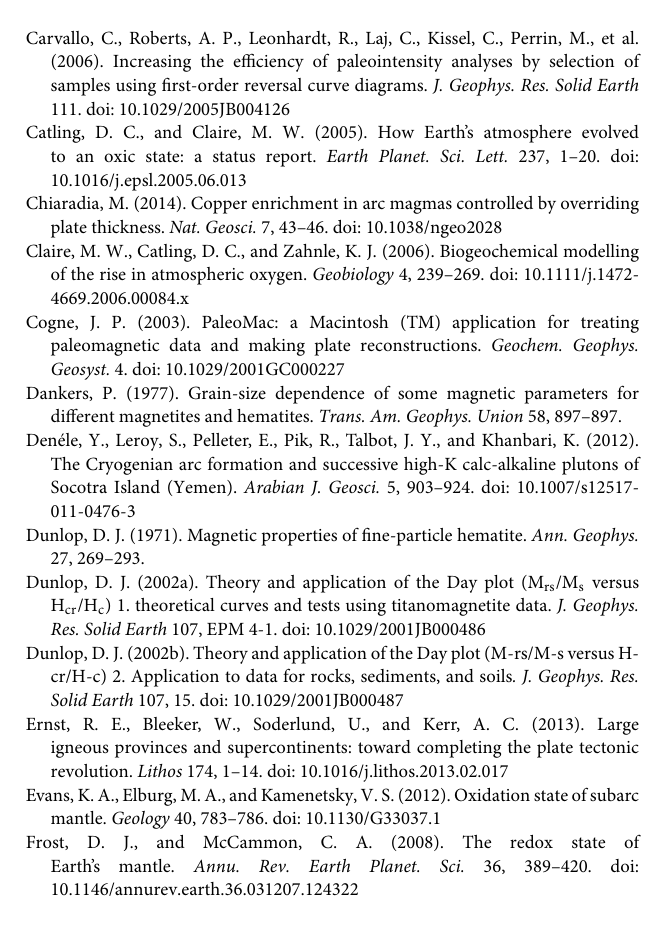
Table S1 | Isothermal remanent magnetization (IRM) acquisition data showing the repartition of magnetic components for each rock formation of Socotra. Table S2 | Hysteresis parameters, susceptibility and remanent magnetization of each selected rocks of Socotra basement. Hcr is